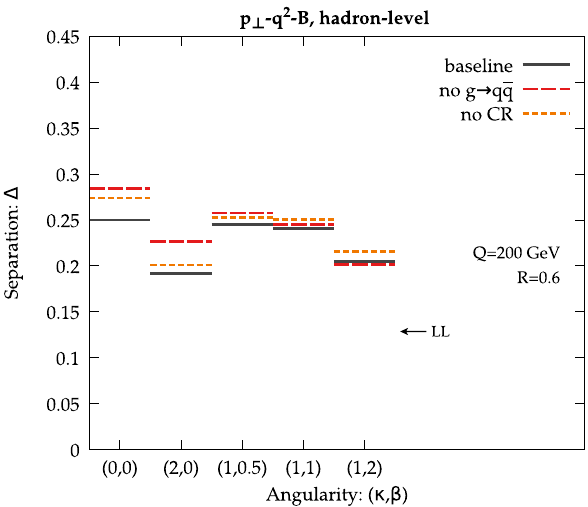
Fig. 15 Settings variations for Herwig 7.1 p ⊥ – q 2 –B tuning. Hadron- level results for the classifier separation (cid:12) derived from the five bench- mark